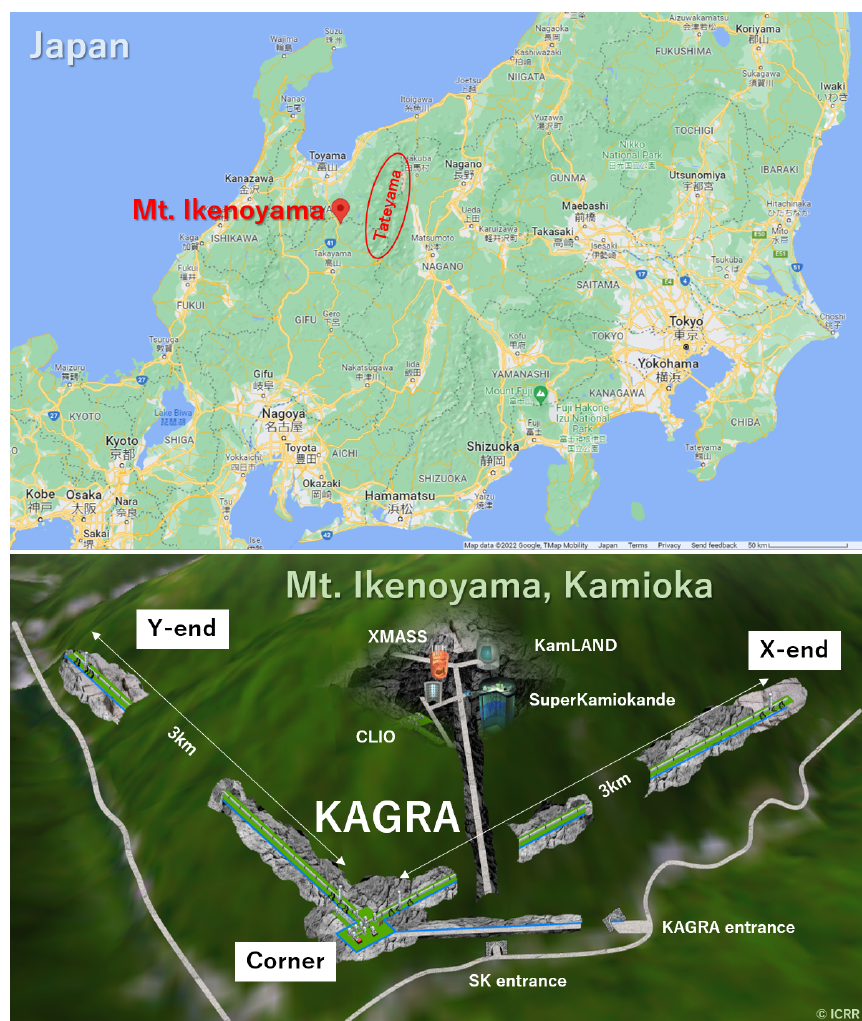
Figure 1. Location and schematic view of the KAGRA experimental site